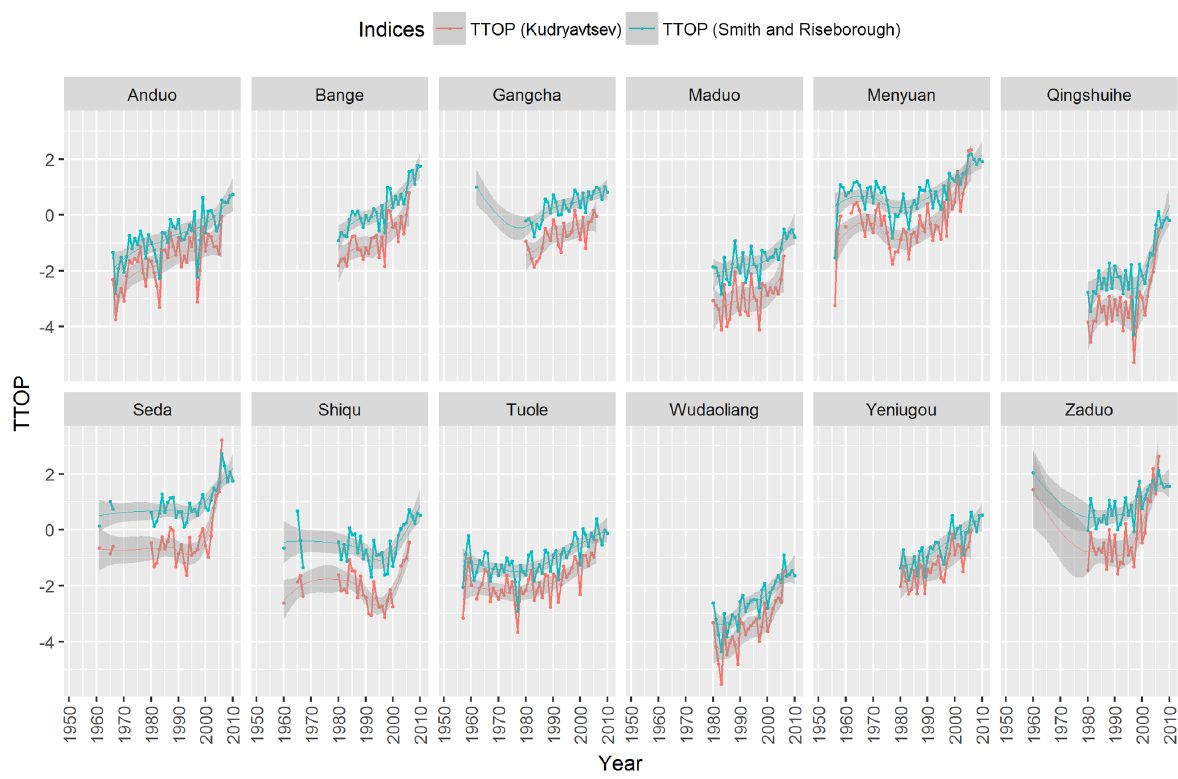
Figure 5. TTOP using the Smith and Kudryavtsev functions.